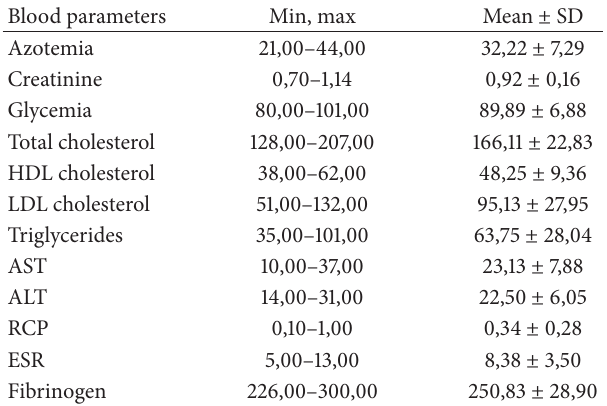
Table 2: Baseline blood values of healthy